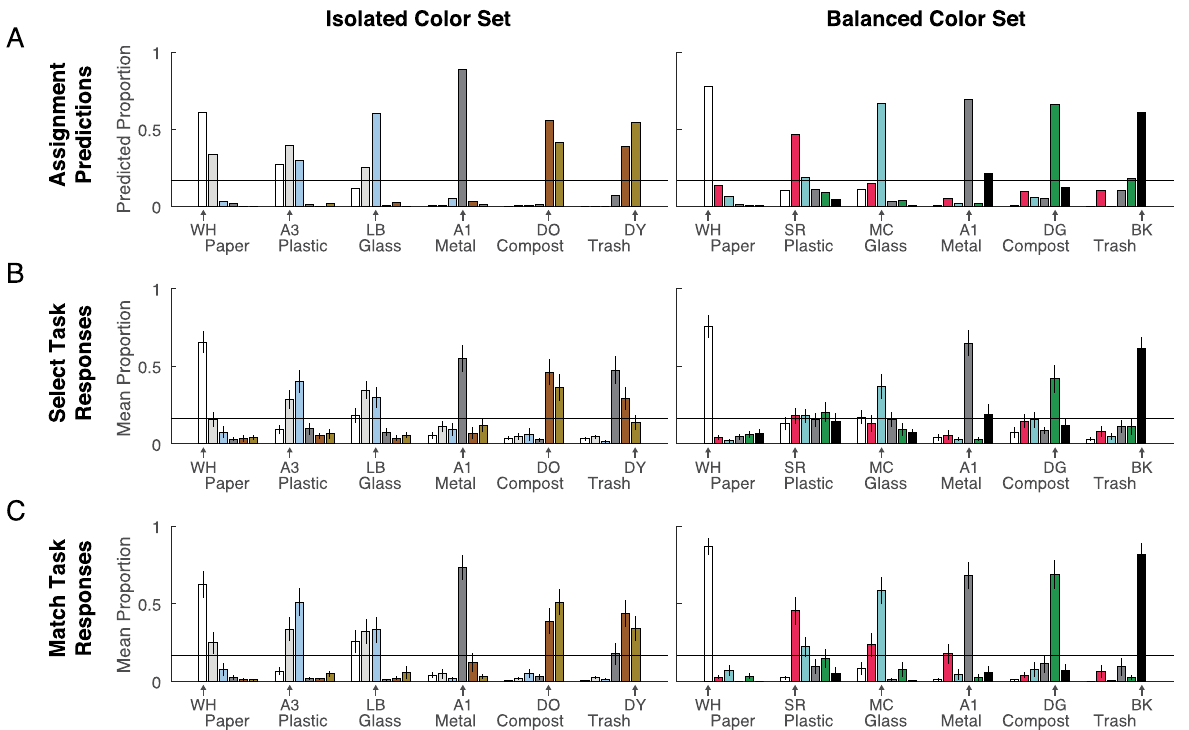
Fig. 11 a Predictions of the proportion of times each color would be chosen for each object within the isolated color set and the balanced color set. b Mean proportion of times each color was chosen for each object within the isolated and balanced color sets for the select task and ( c ) for the match task. The correct response for each object is marked along the x-axis by an arrow with the color name pointing up at the correct color. Error bars represent the ± standard errors of the mean proportion across participants within each